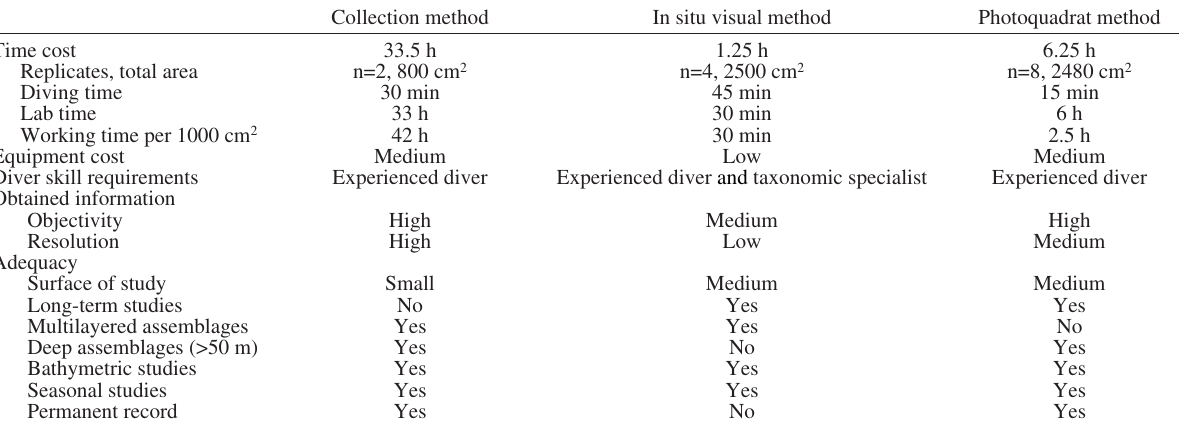
Table 3. – Comparison of the cost and requirements of the three methods